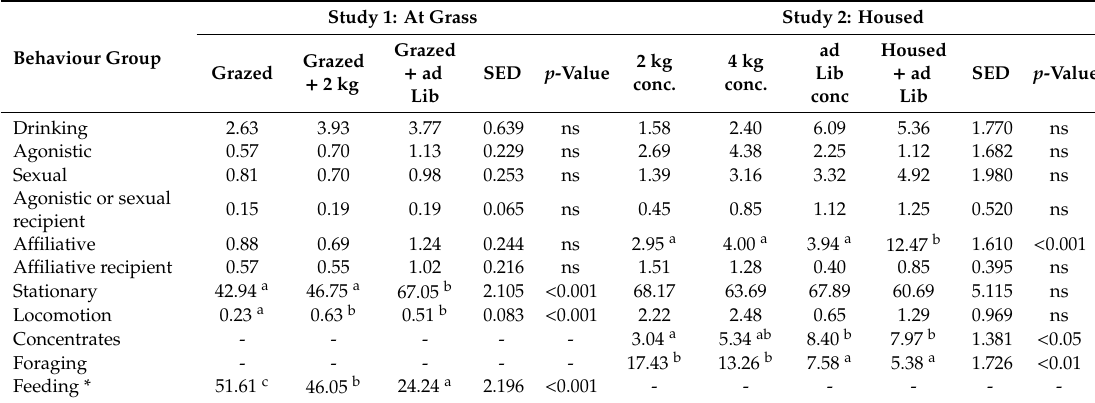
Table 4. Incidence rate (%) of behaviours according to diet during Study 1 and Study